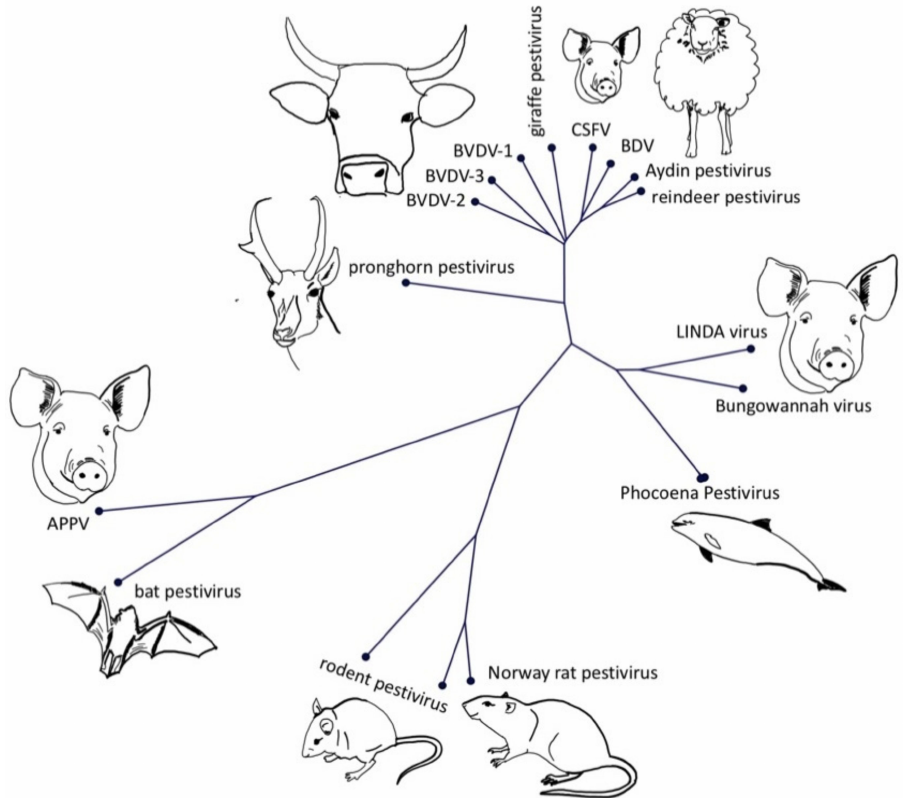
Figure 2. Neighbour joining tree (1000 replicates) of the polyprotein of representatives of different pestivirus species and isolates. GenBank accession numbers of the isolates are: APPV AQM73625, Aydin-like pestivirus YP_006860588.1, bat pestivirus AYV99177.1, BDV AAC16444.1, Bungowannah virus YP_008992092.1, BVDV-1 AYA62524.1, BVDV-2 AMO65207.1, BVDV-3 AGO04420.1, CSFV CAA65386.1, LINDA virus YP_009407716.1, Norway rat pestivirus YP_009109567.1, pestivirus giraffe NP_620053.1, pestivirus isolate reindeer AAF02524.2, phocoena pestivirus QFQ60724.1, pronghorn antelope pestivirus YP_009026415.1, rodent pestivirus ATP66856.1 and ATP66855.1. The phylogenetic tree was generated with CLC Sequence Viewer and the multiple sequence alignment with